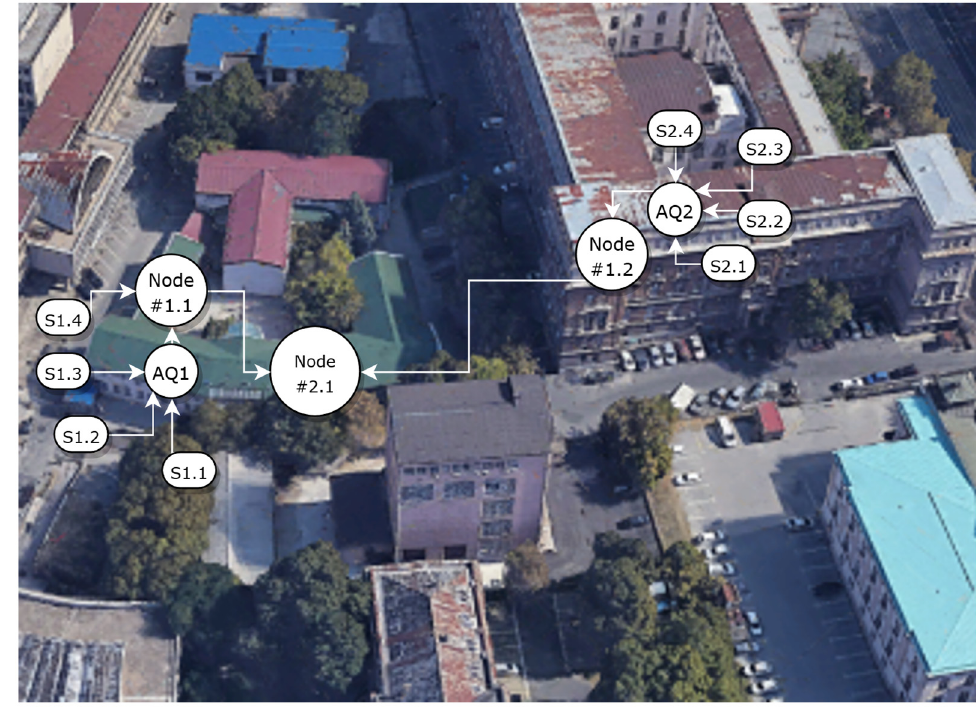
Figure 6. Deployment set up.